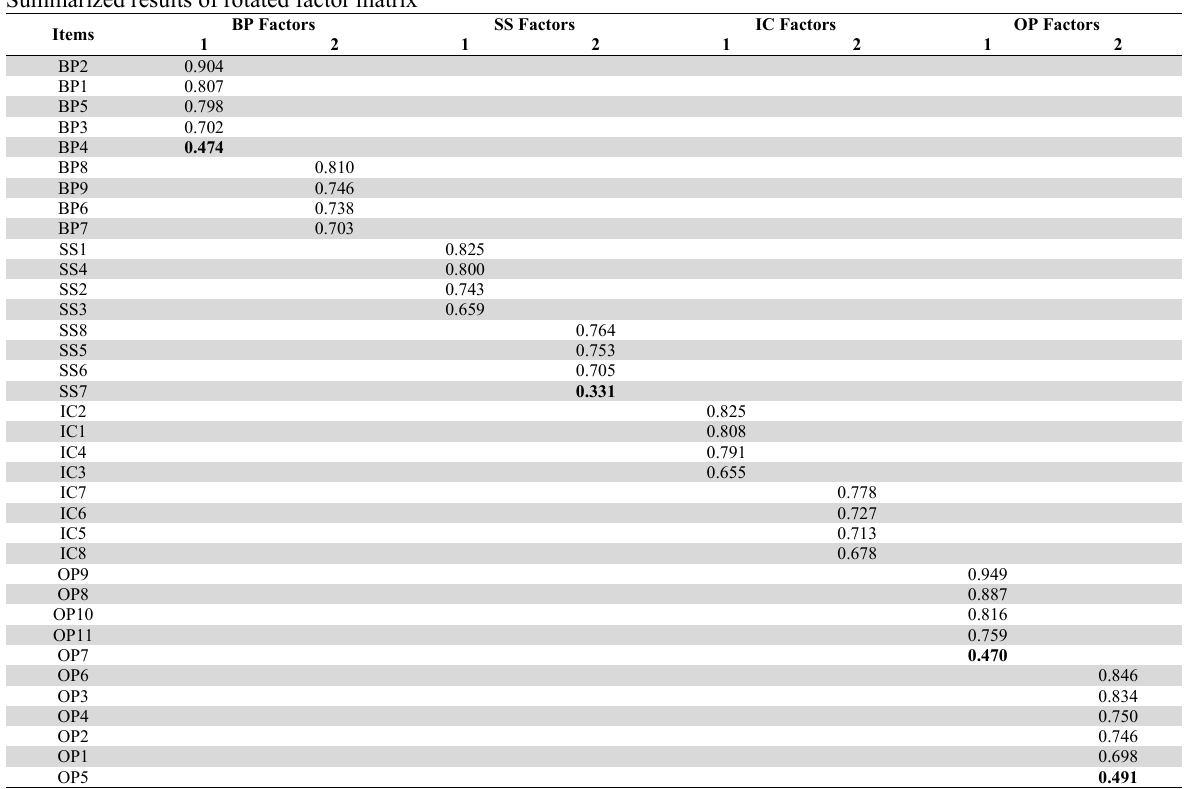
Table 1 summarized the results of the rotated factor matrix for each variable, where four items with factor loadings < 0.60 were removed one by one with re-running the analysis for that specific variable. Resultantly, 32 items were retained for further analysis with no cross-loadings > 75% on any other item, and the eigenvalues of one were opted to extract the number of factors (Hair et